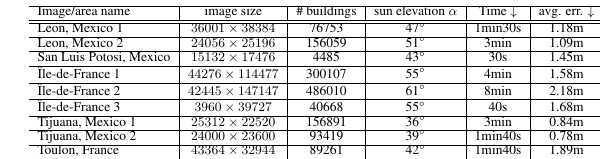
Figure 11. BrightEarth: online and on-the-fly service of our operational pipeline to reconstruct 2D land use (top right), urban scene in 3D (left bottom) with DSM (left right) anywhere in the world from an area of interest (bottom right), Grenoble France Area